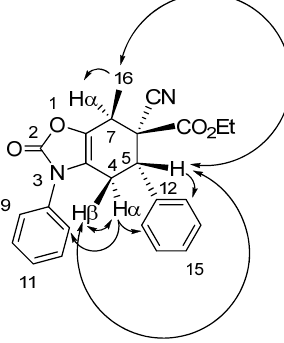
Figure 3. NOE observed upon irradiation of protons H-4 β , H-5 and H-16 for the adduct 13a .